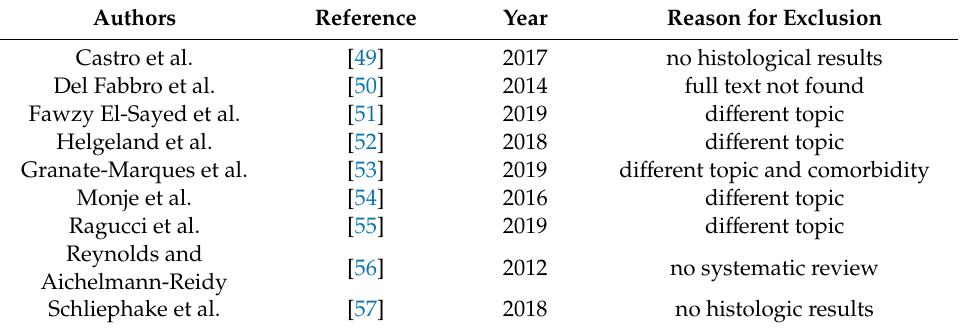
Table 2. Excluded